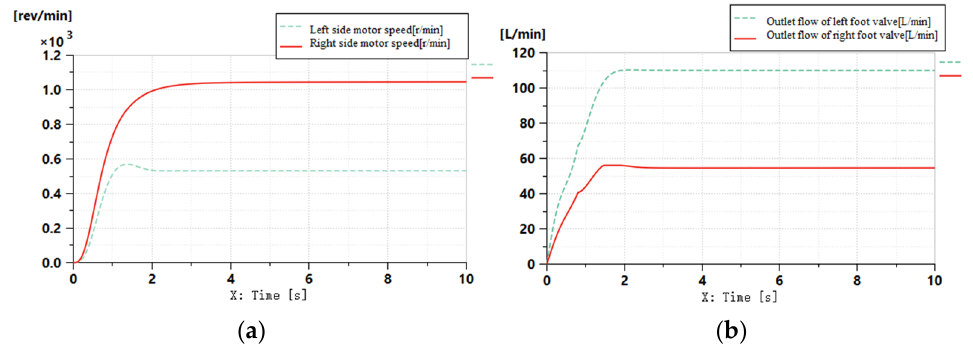
Figure 7. Simulation analysis of field-turning conditions: ( a ) hydraulic motor speed, ( b ) variable displacement pump outlet flow.